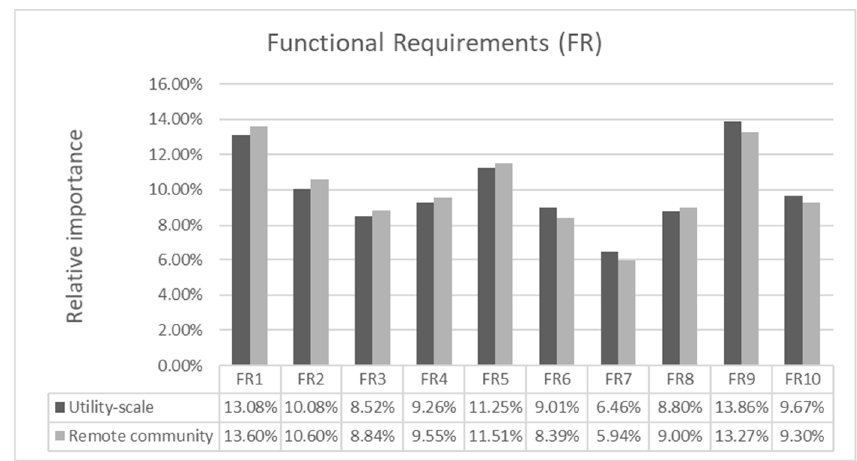
Figure 14. Relative importance of FR for the application market.